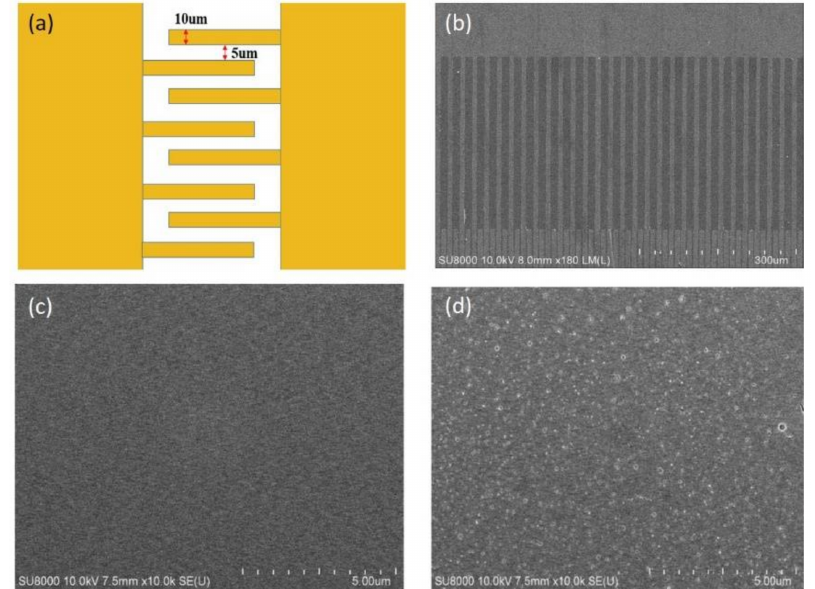
Figure 2. ( a ) The pattern of the interdigitated electrodes. ( b ) SEM image of the fabricated interdigi- tated electrodes. SEM image of the ( c ) magnesium titanate (MTO) thin film and the ( d ) magnesium zirconate titanate (MZT) thin